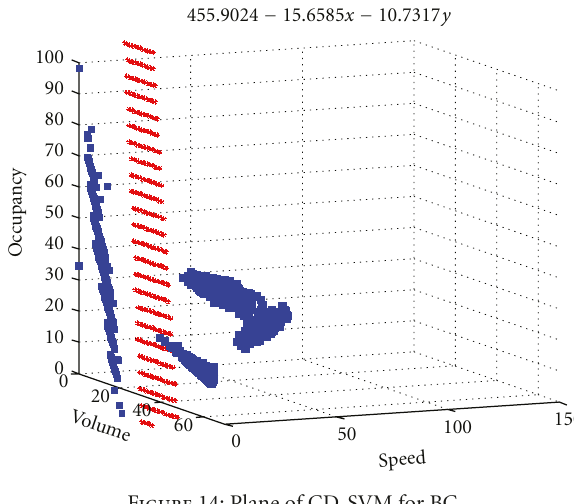
Figure 14: Plane of CD-SVM for BC.